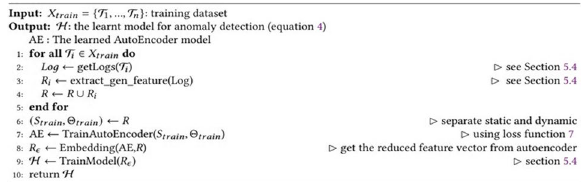
Algorithm 2 requires three inputs, namely, the